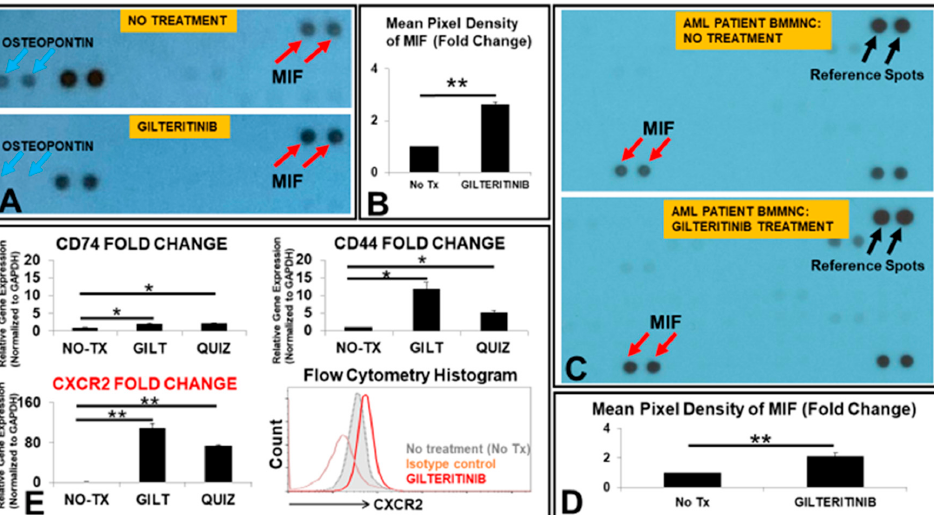
Figure 1. MIF was released more by TKI-treated AML blasts in vitro and ex vivo. ( A ) Image of partial blot films developed for proteomic analyses of cell-free supernatants from 80 nM gilteritinib (GILT)-treated MV4-11 cells. The blue arrows indicate the dots of Osteopontin at the same location in the film. The red arrows indicate the dots of MIF at the same location in the film. Note: Each antibody has two dot spots according to the manufacturer’s specification. ( B ) Cumulative Mean Pixel Densities of MIF (Fold Change); ( C ) Image of partial blot films developed for proteomic analyses of cell-free supernatants from 80 nM GILT-treated primary AML BMMNC cell (Patient #1). The black arrows indicate the reference spots (control dots) from the manufacturer. The red arrows indicate the dots of MIF at the same location in the film. ( D ) Cumulative Mean Pixel Densities of MIF (Fold Change from AML BMMNC, Patient #1); ( E ) 3 days after the treatment of 80 nM gilteritinib (GILT) or quizartinib (QUIZ) in vitro, the cells were collected for RNA isolation and gene expressions were analyzed by qPCR. Data show mRNA expressions of the genes encoding different receptors CD74, CD44 and CXCR2 for MIF; Representative FC histogram plot of CXCR2 expression in GILT-treated MV4-11 cells after 3 days in vitro; * p < 0.05, ** p <